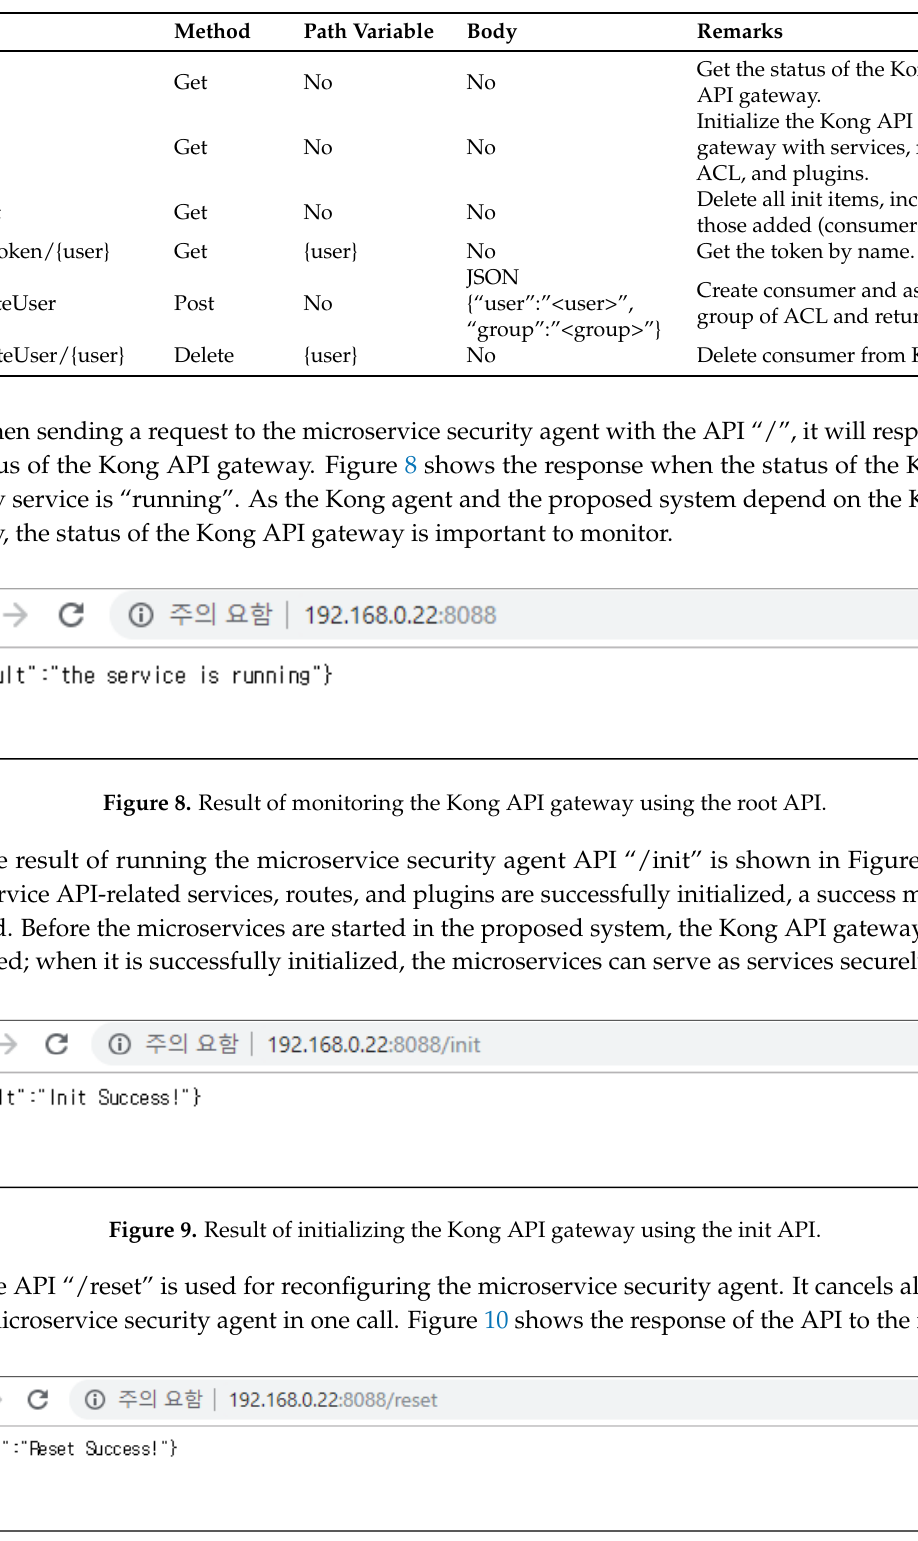
Table 2. Specifications of the microservice security agent REST APIs.